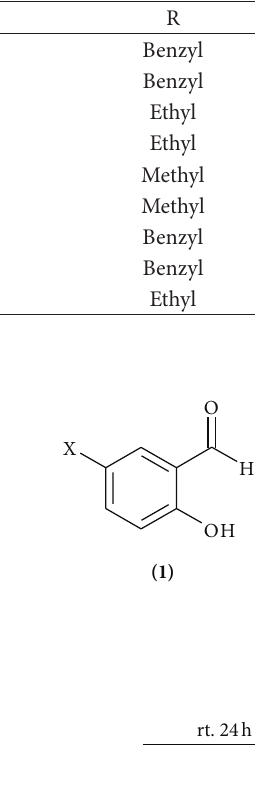
Table 1: Condition and yield of reactions for synthesis of benzo[ b ]furan derivatives, 7a–i , in water.